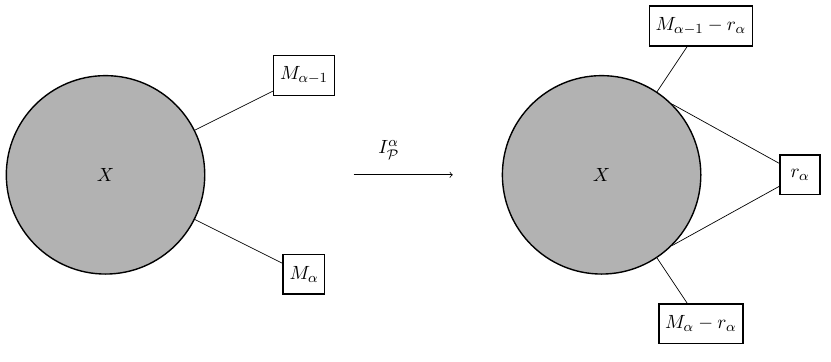
Figure 20 . Identification